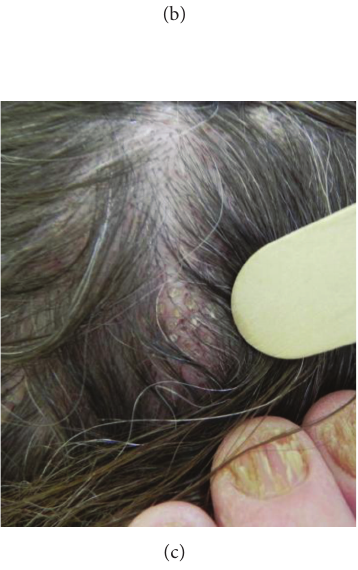
Figure 5: In the nose, ears, and scalp, are visible skin colored papules, with a few mm size, clearly localized by healthy skin (a, b, and